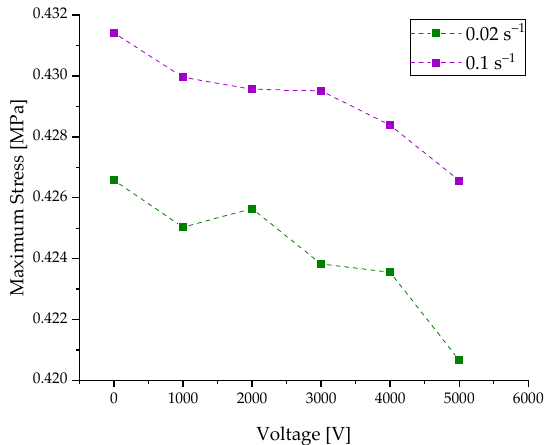
Figure 7. Voltage dependencies of the maximum stress values during the hysteresis loops for two different strain rates (0.02 s − 1 and 0.1 s − 1 ).